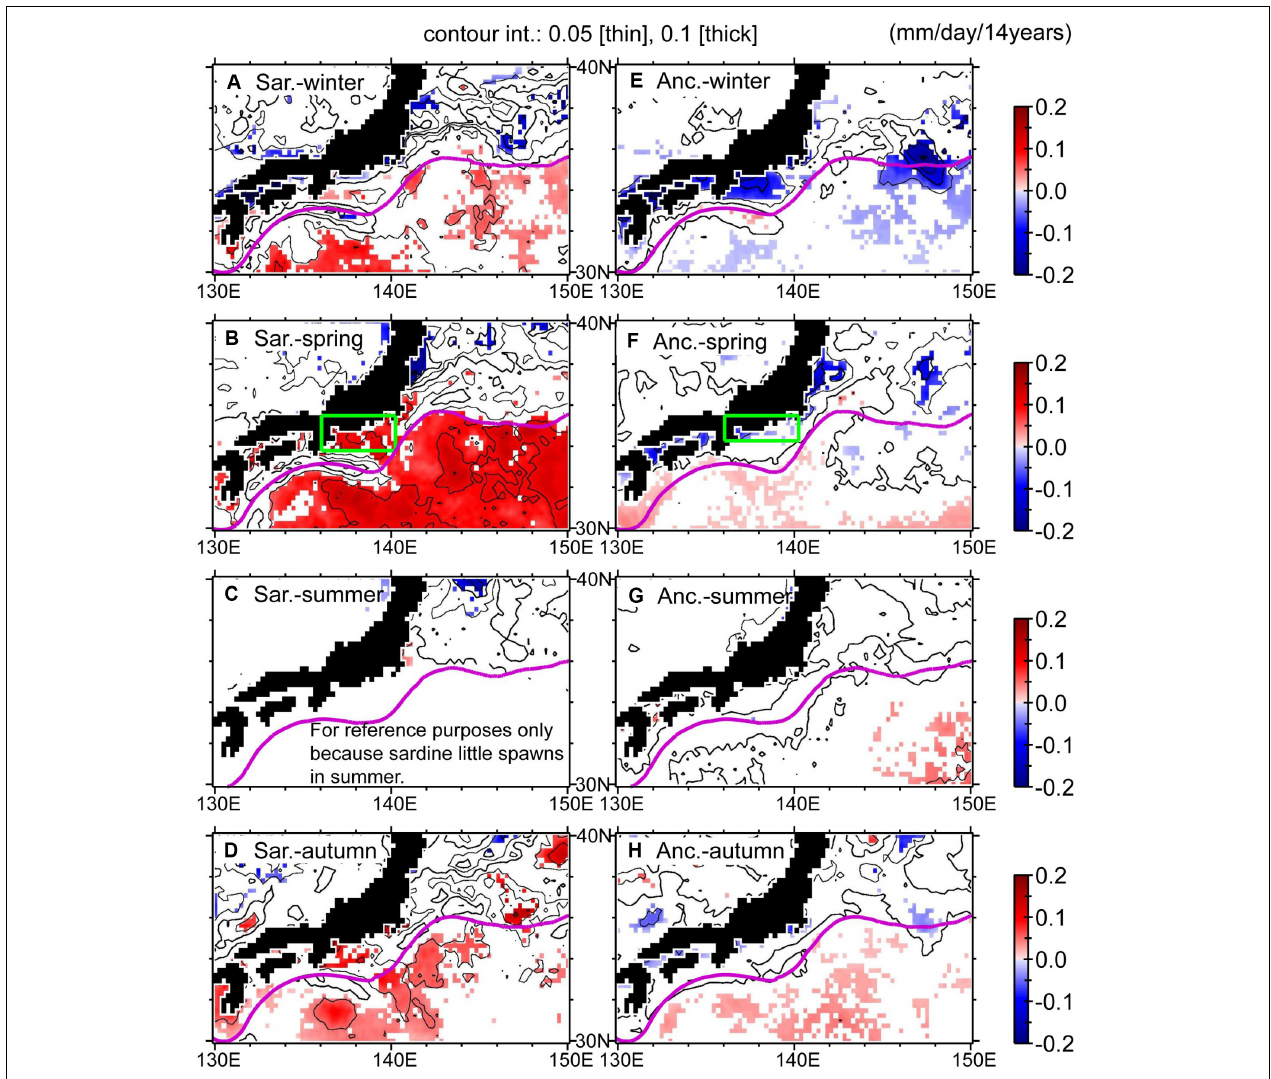
FIGURE 11 | Trends for 2000–2014 in potential larval growth rate of Japanese sardine: (A) winter, (B) spring, (C) summer, and (D) autumn. (E–H) Same as (A–D) , but for Japanese anchovy. Display style is the same as in Figure 4